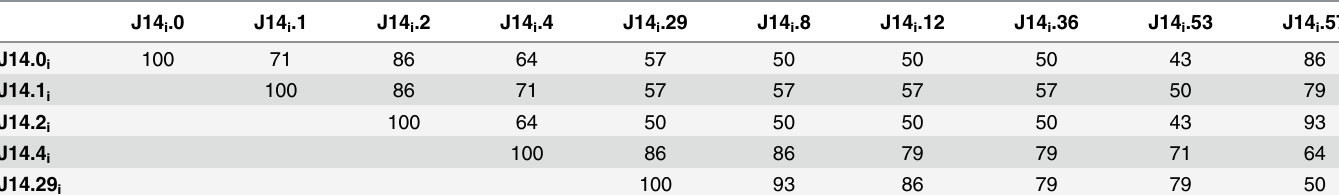
Table 5. Percent identity between J14 i peptides.